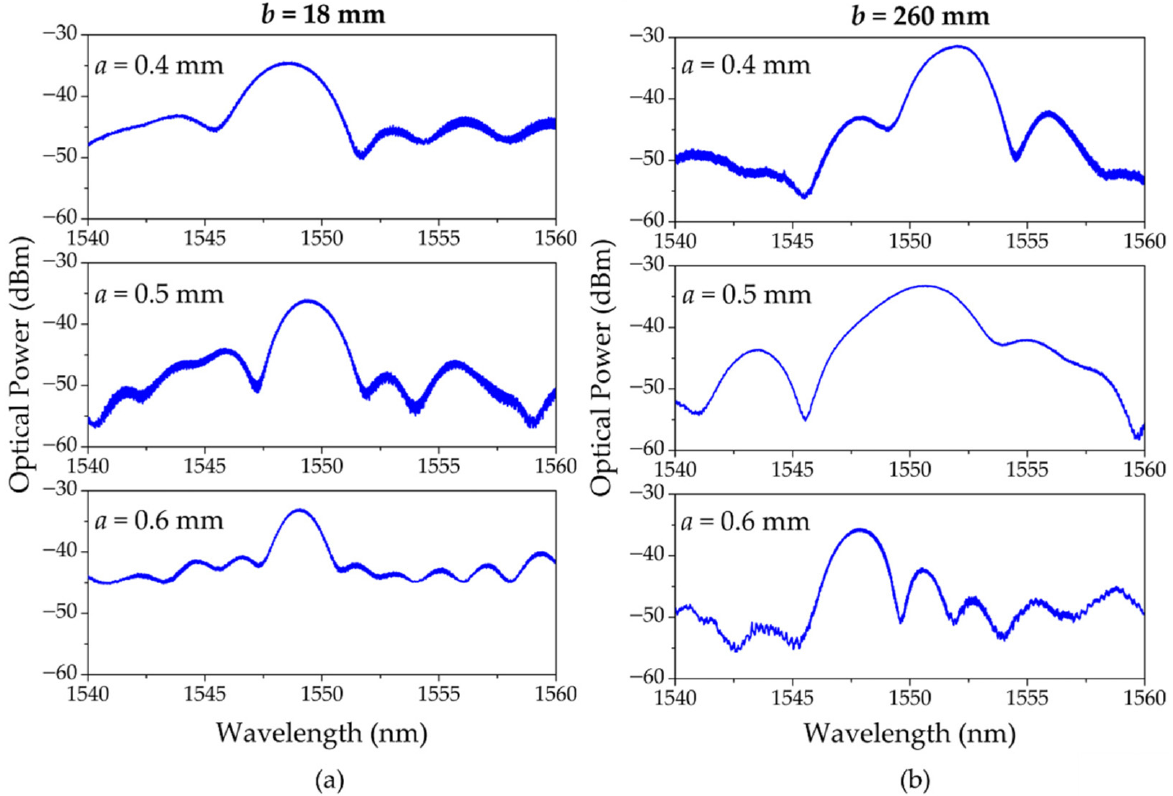
Figure 6. Reflected spectra of the produced USPOFBGs with different slit widths when ( a ) b = 18 mm; ( b ) b = 260